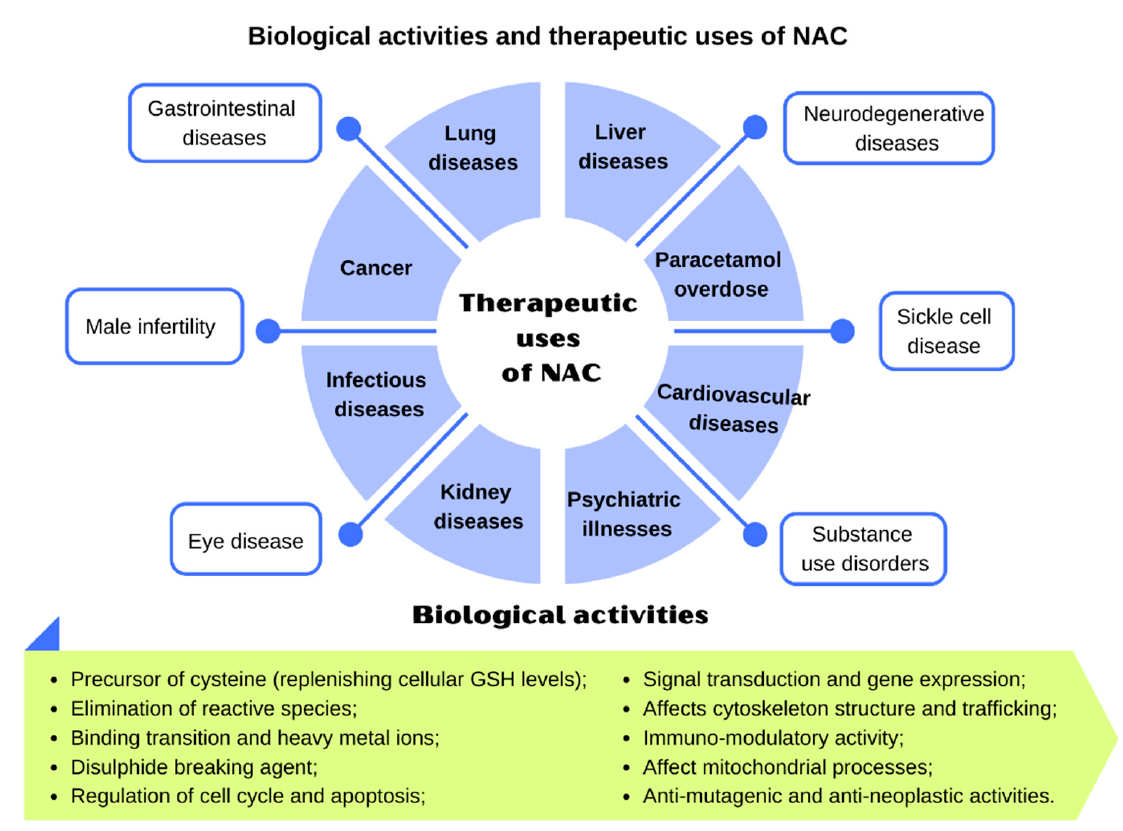
Figure 3. Biological activities and therapeutic uses of N -Acetylcysteine. Adapted from Samuni et al. (2013) [34]. Table 2. Studies carried out with N -acetylcysteine in different clinical conditions. Disease